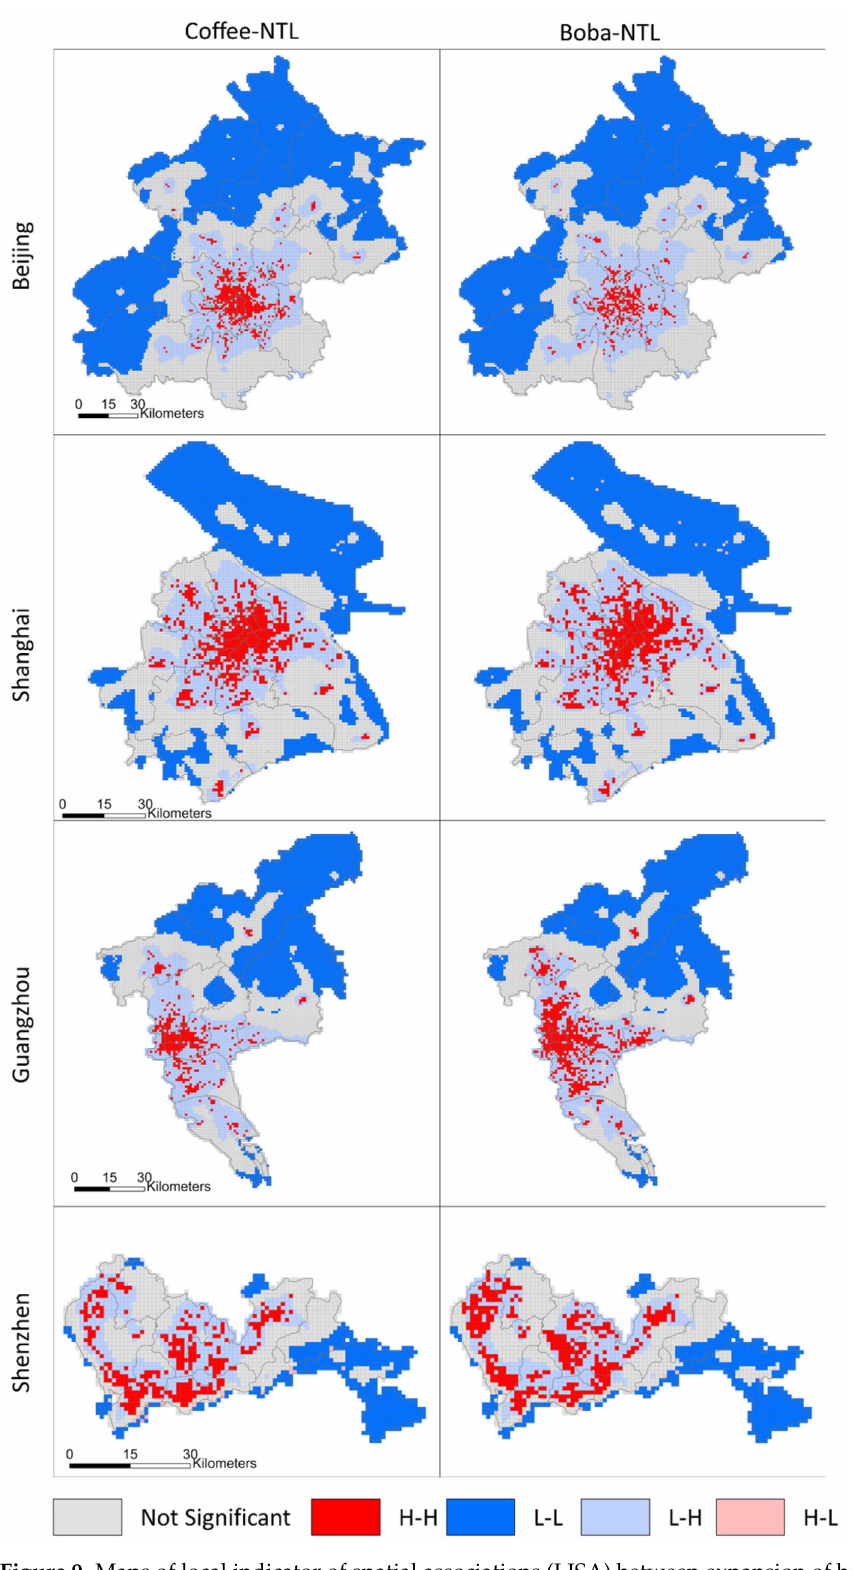
Figure 9. Maps of local indicator of spatial associations (LISA) between expansion of boba tea shops or coffee shops and nighttime urban vitality for four cities in China in